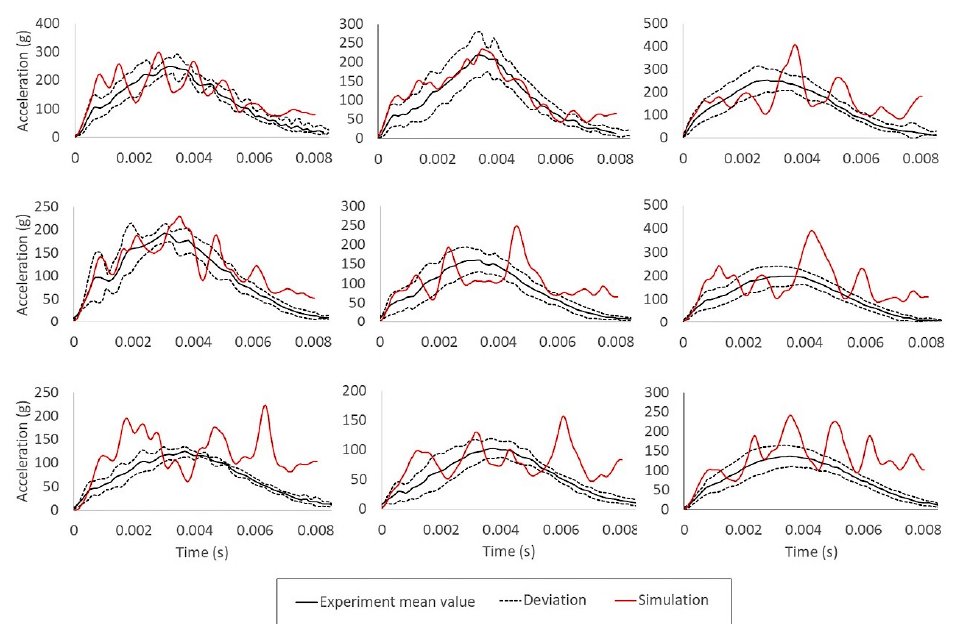
Figure 13. Comparison between the experimental acceleration response expressed as mean ± one standard deviation and the results from the simulations for all the nine cases: impact velocities: 6 m / s, 4.9 m / s, and 3.5 m / s; location: anterior, posterior, and contra-lateral).